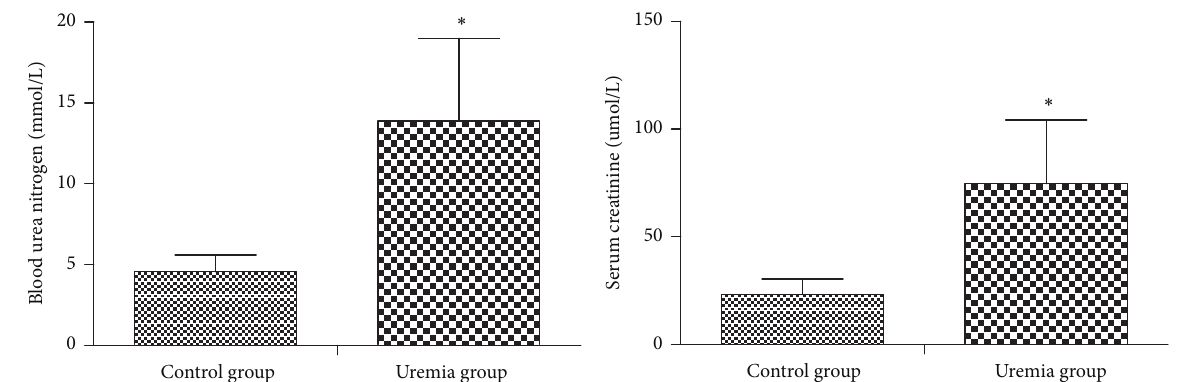
Figure 1: Serum levels of blood urea nitrogen and creatinine in each group in postoperative week 4. Data are expressed as mean ± SD. ∗ 𝑃 < 0.05 , versus control group.